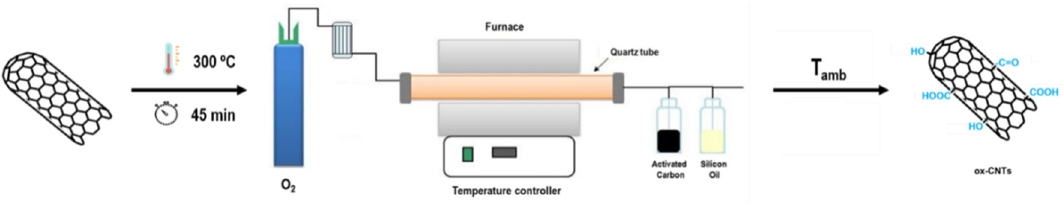
Figure 2. Schematic representation of the thermal oxidation of CNTs.